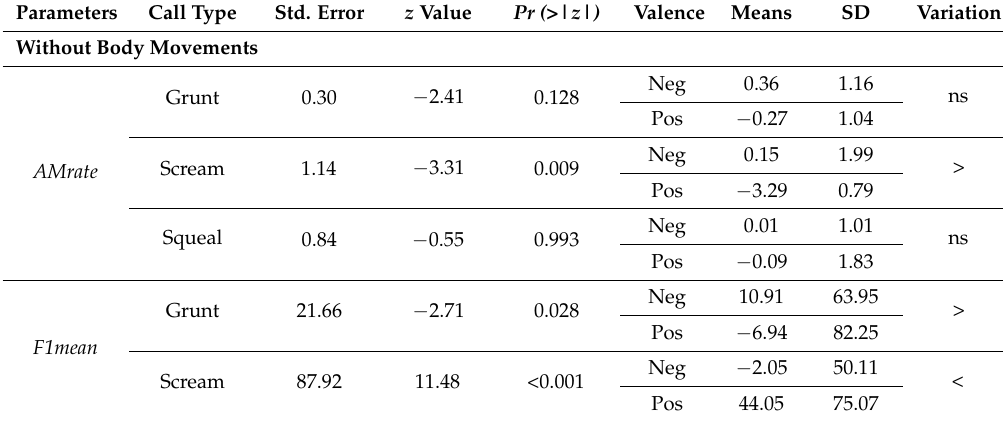
Table 7. Effect of the interaction between the emotional valence of the recording situations and call type (only significant values are shown); residuals of the models with and without body movement as a control factor. The models were controlled for the following factors: sex, age, size of the group, and valence (see Supplementary Table S3 for raw values). The direction of the effect is displayed (< denotes an increase from negative to positive valence; > denotes a